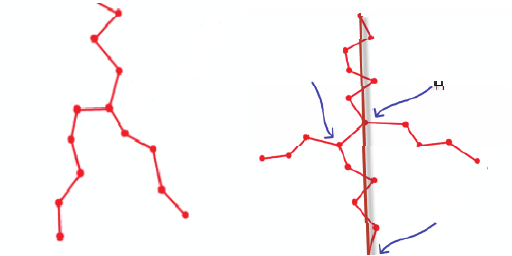
Fig. 3. Extraction of distance of movement: (a) skeleton of the object and (b) axis